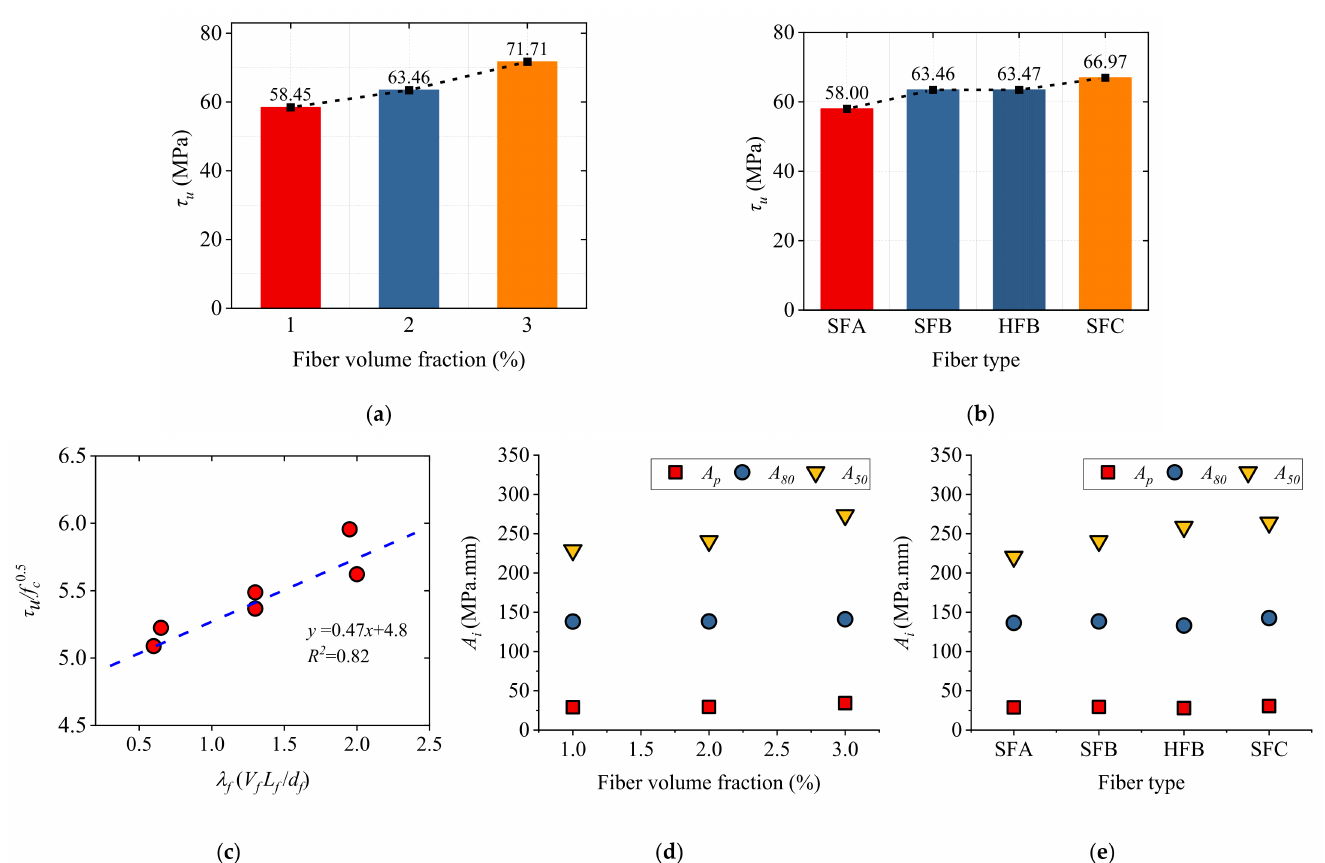
Figure 9. Effect of steel fiber on bond performance: ( a ) bond strength-fiber volume fraction; ( b ) bond strength-fiber type; ( c ) bond strength-fiber characteristic factor; ( d ) bond toughness-fiber volume fraction; ( e ) bond toughness-fiber type.